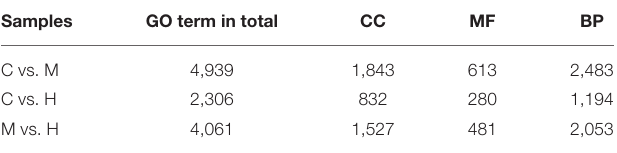
TABLE 5 | Summary of GO term